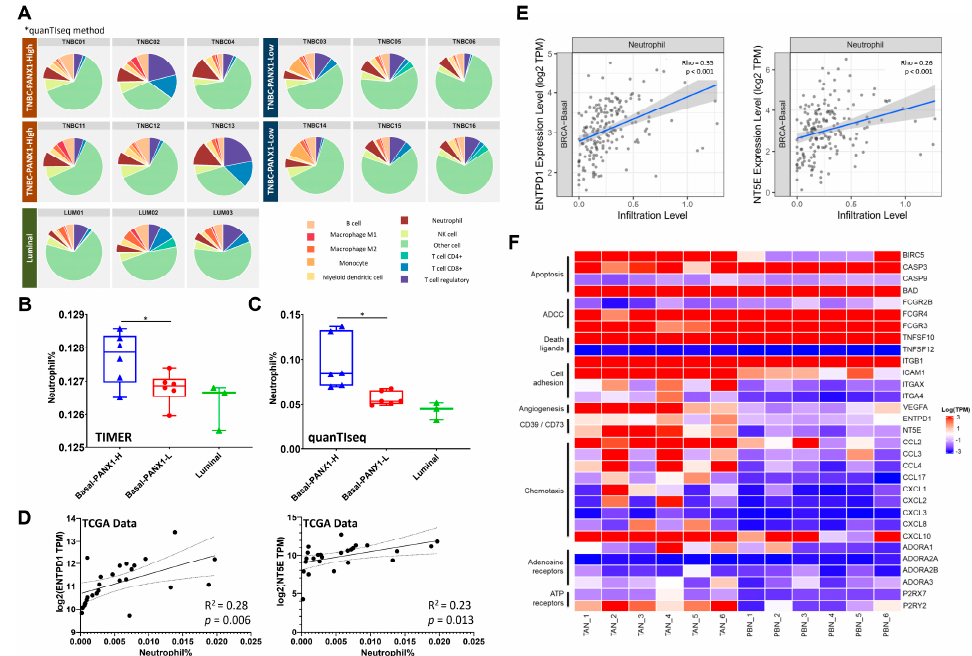
Figure 4. ( A ) The proportion of infiltrating TANs in Luminal (n = 3) and basal-like subtype (High PANX1 expression: n = 6; low PANX1 expression: n = 6) surgical specimens; ( B , C ) basal-like breast cancer with high PANX1 expression had more infiltrating TANs than basal-like breast cancer with low PANX1 expression and the Luminal subtype ( p < 0.05 for TIMER; p = 0.11 for quanTIseq; Student’s